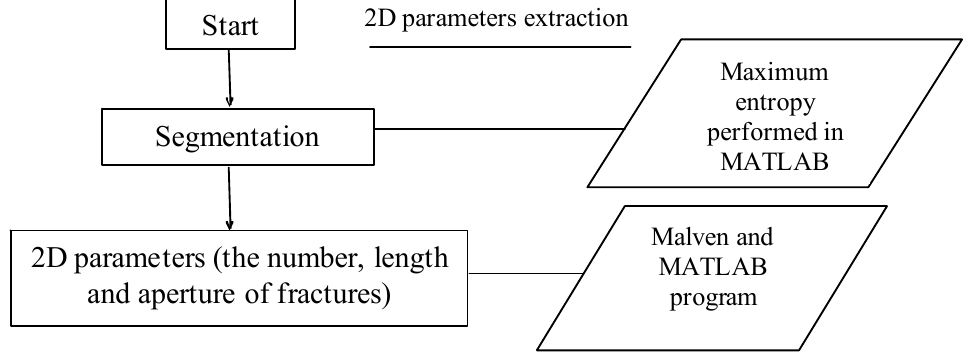
Figure 11. CT-scan grayscale imaging of oil shale after pyrolysis.